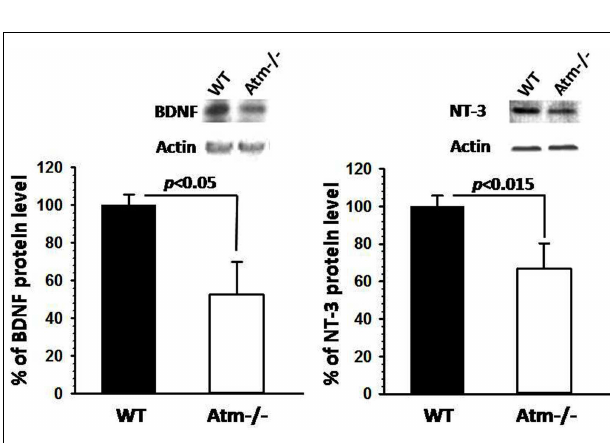
FIGURE 2 | Reduction in neurotrophic mediators Atm − / − mice. Western blot analysis displaying reduction in BDNF and NT3 (protein levels in Atm − / − mice ( n = 3) and NT3 ( n = 3). Error bars represent SEM (statistical analysis was performed using two-tailed Students t